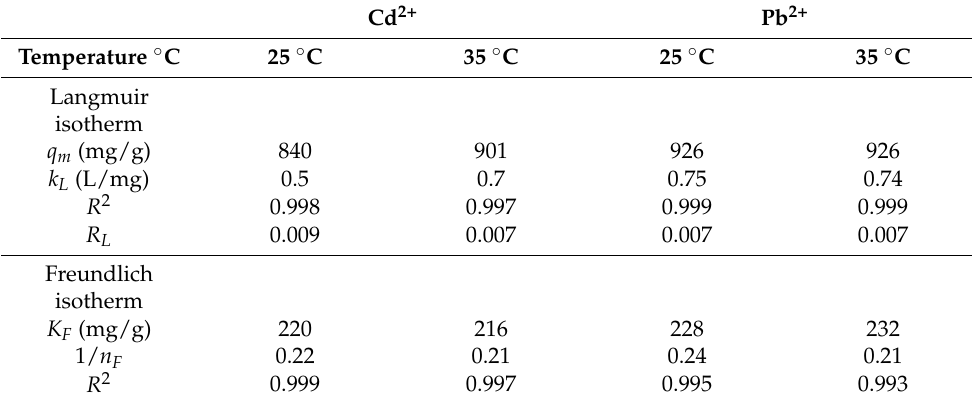
Table 2. Adsorption isotherm parameters for the adsorption Cd 2+ and Pb 2+ adsorption on